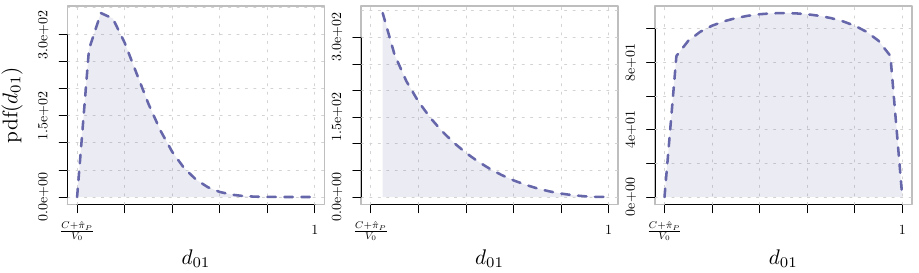
Figure 3. Different behaviors of the bidders modeled by alternative parameterizations of the Beta distribution in Equation (33). Left panel : α = 1.80, β = 7.20. Central panel : α = 0.80, β = 3.20. Right panel : α = 1.16, β =